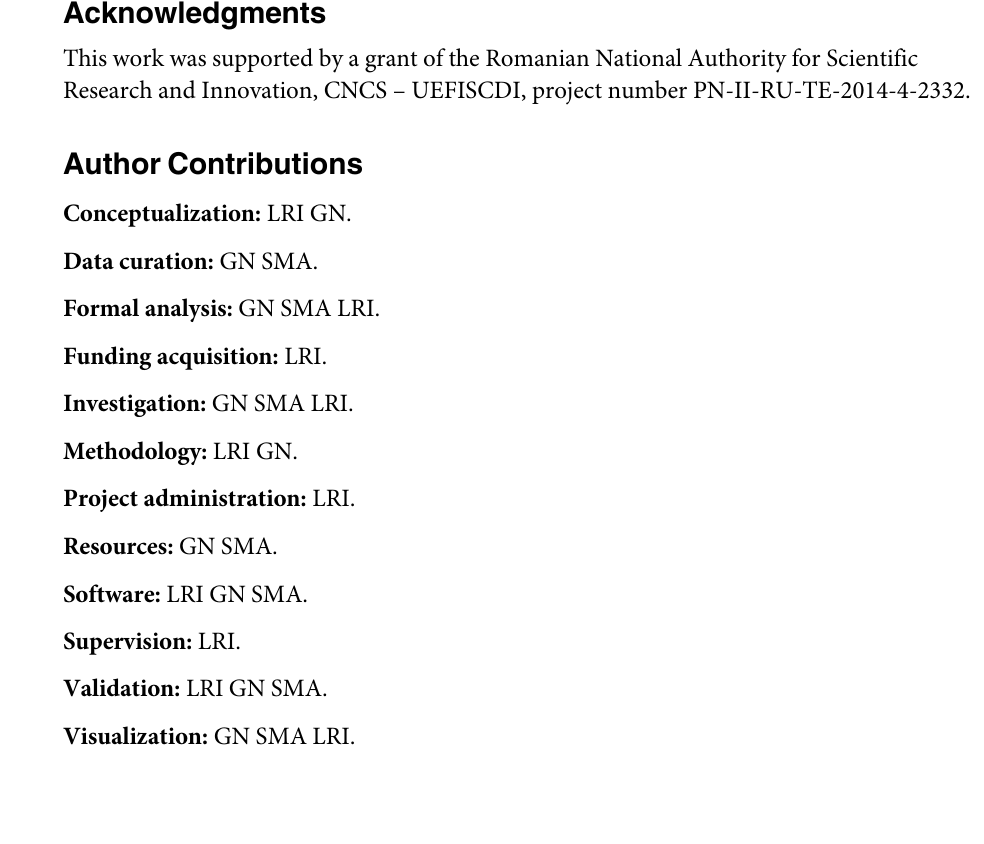
S1 Fig. GN z = {1, . . . , 5}; boxplots of NMI values for all methods considered (left). On out the right, the black-white matrix represents Wilcoxon h values for each pair of methods con- sidered, numbered in the order they appear in the boxplot. A black square indicates a statistical difference between results. As these networks have very well defined community structures, all methods are capable to identify the correct structure. S2 Fig. LFR small, 128 nodes; boxplots of NMI values for all methods considered (left). On the right, the black matrix represents Wilcoxon h values for each pair of methods considered, numbered in the order they appear in the boxplot. A black square indicates a statistical differ- ence between results. S3 Fig. LFR big, 1000 nodes; boxplots of NMI values for all methods considered (left). On the right, the black-white matrix represents Wilcoxon h values for each pair of methods con- sidered, numbered in the order they appear in the boxplot. A black square indicates a statistical difference between